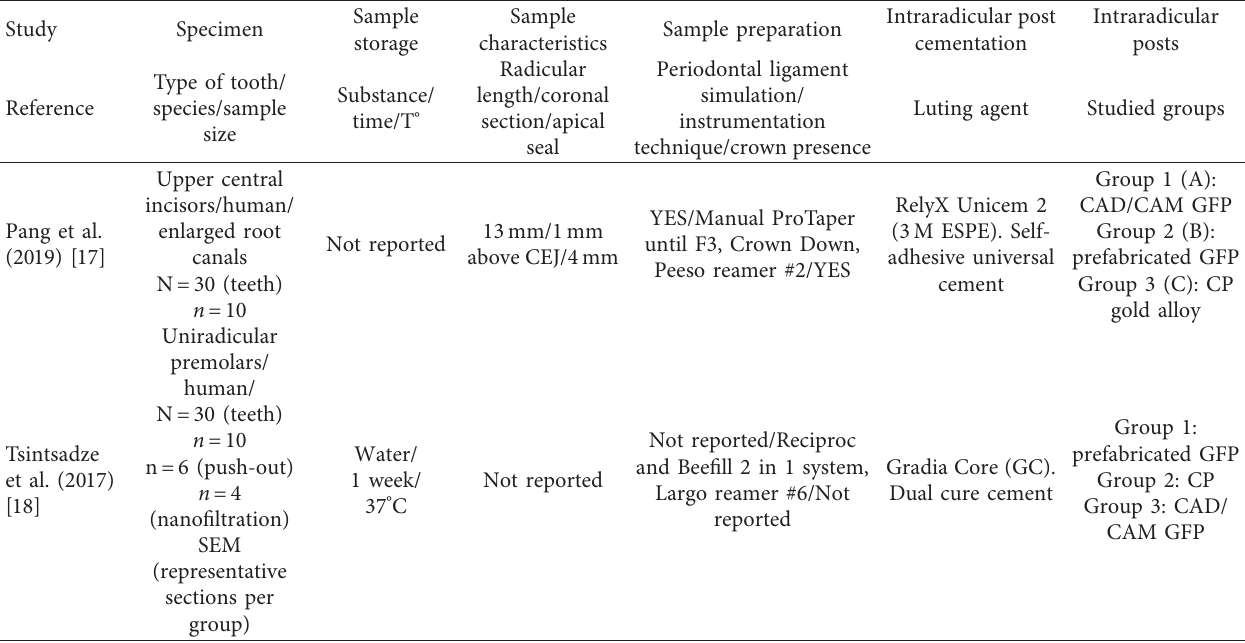
Table 2: Characteristics of the seven studies included in the